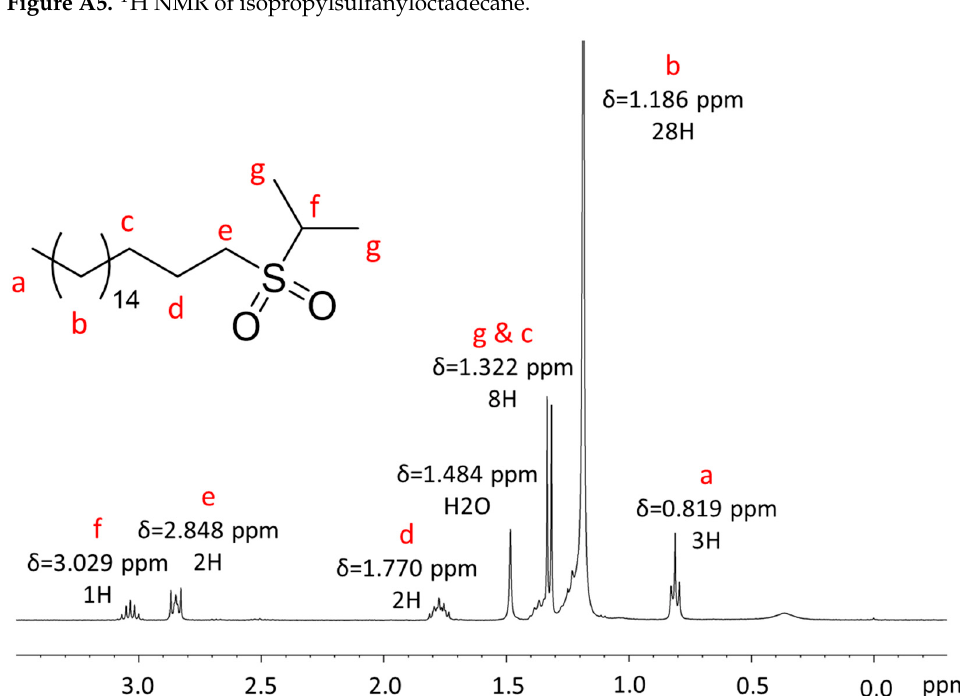
Figure A6. 1 H NMR of isopropylsulfonyloctadecane.